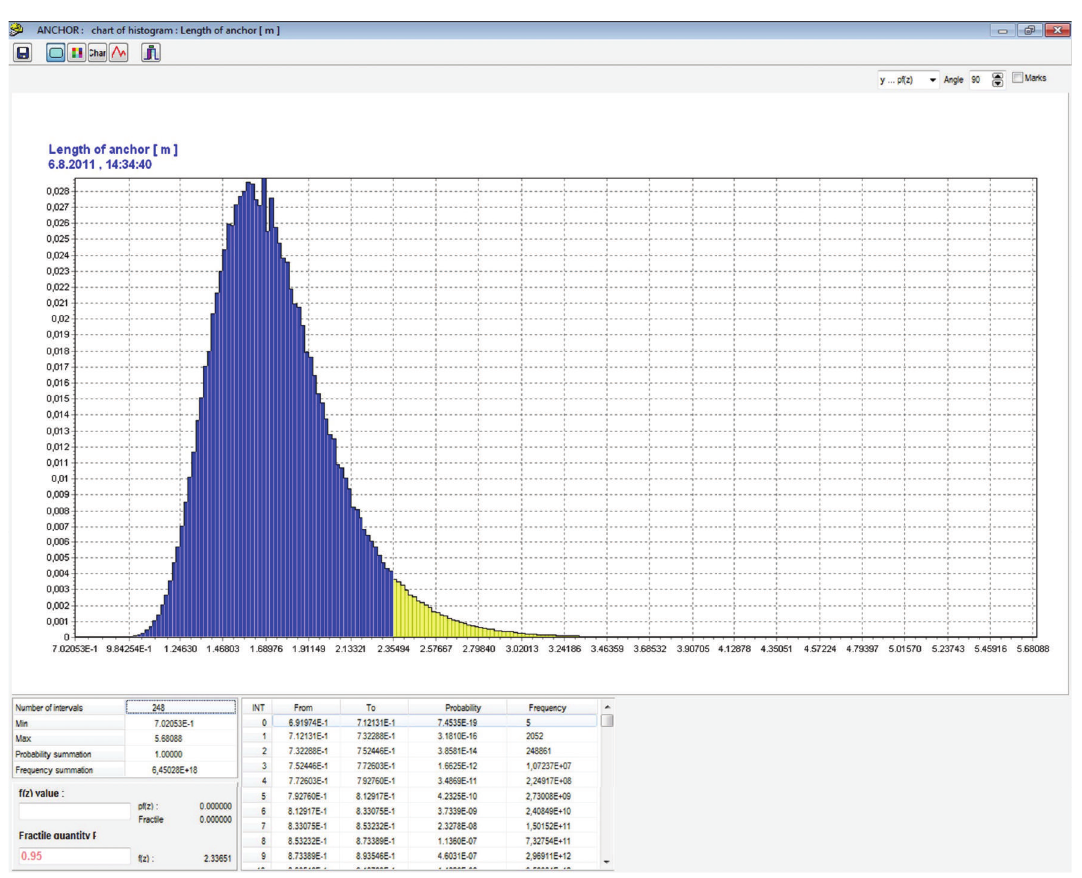
Figure 11: Histogram of the length of the designed bolt 𝑙